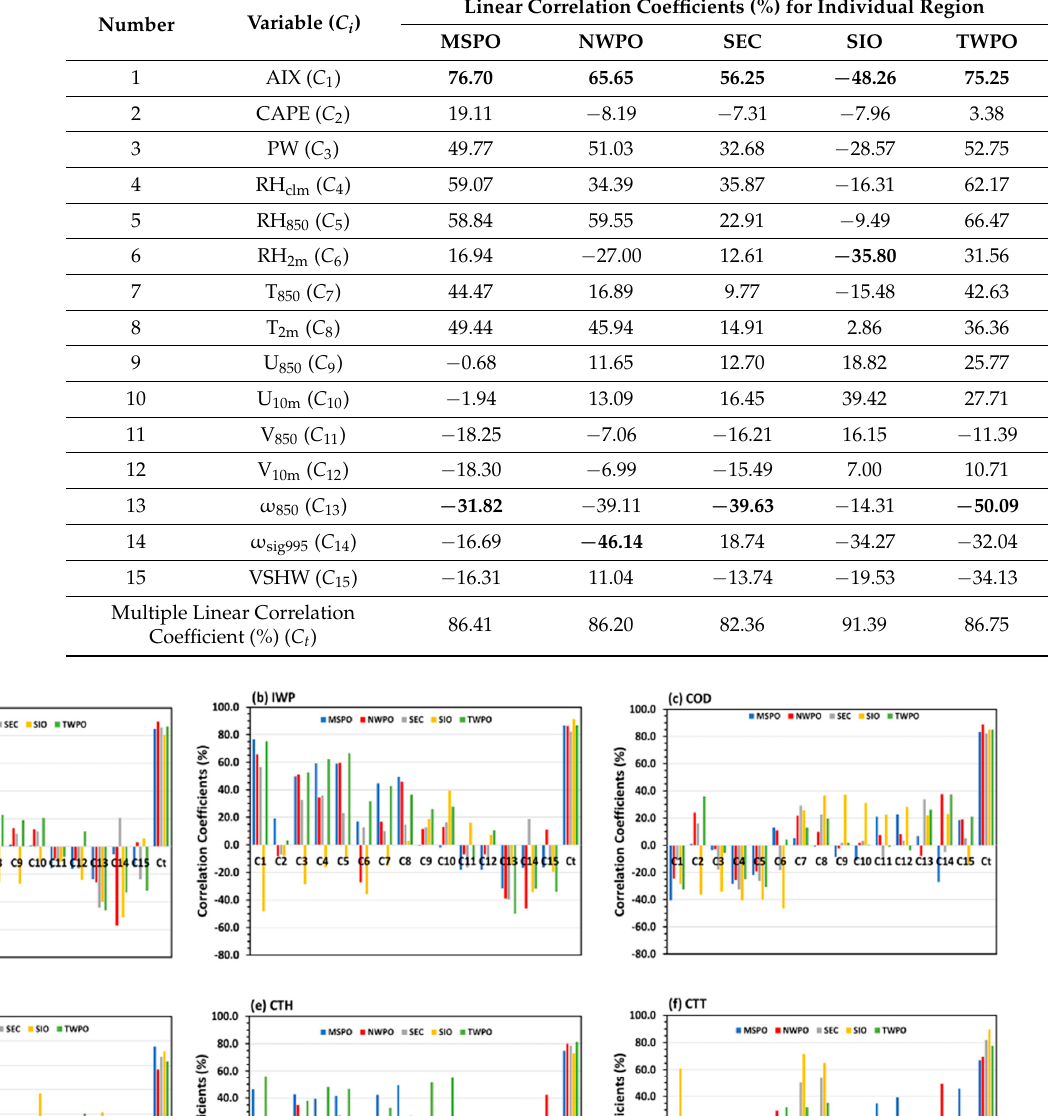
Table 3 . Same as Table 2 but for the cloud microphysical variable IWP.